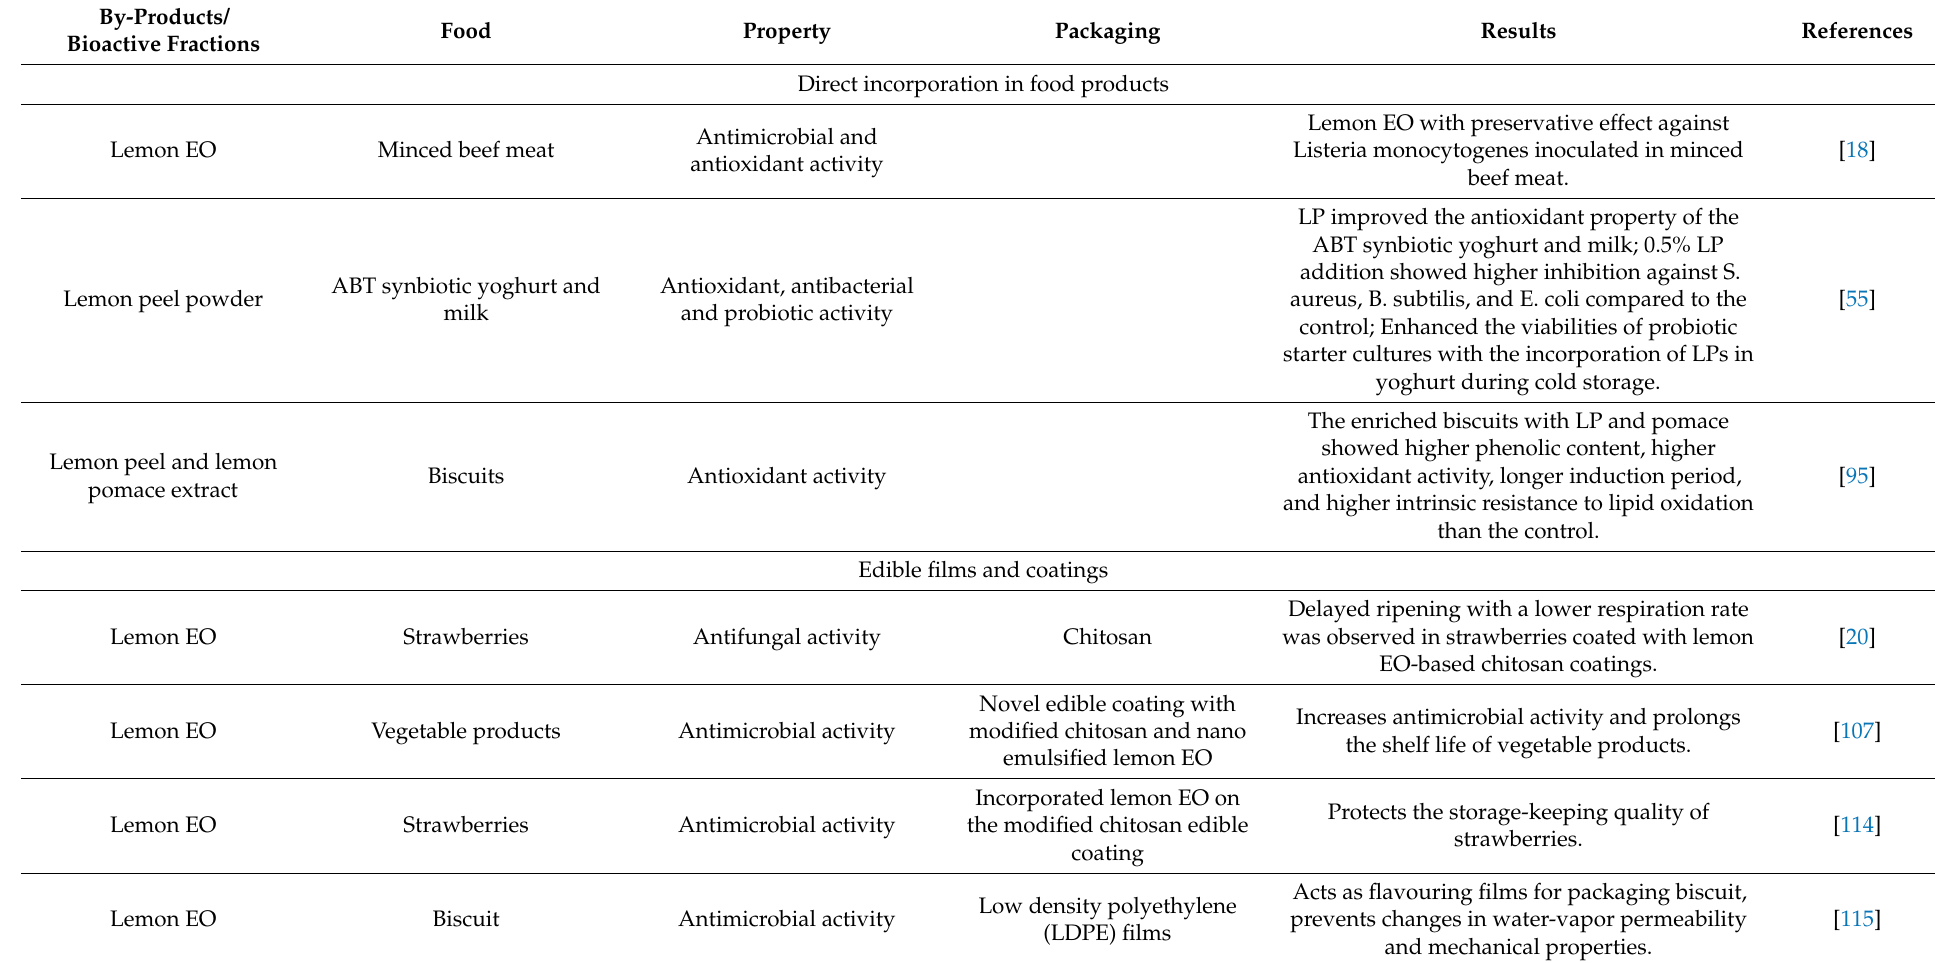
Table 7. Applications of lemon by-products and their bioactive fractions in food